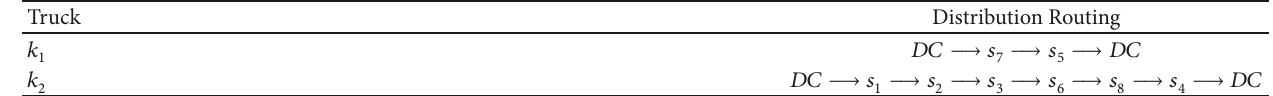
Table 6: Distribution routings of each